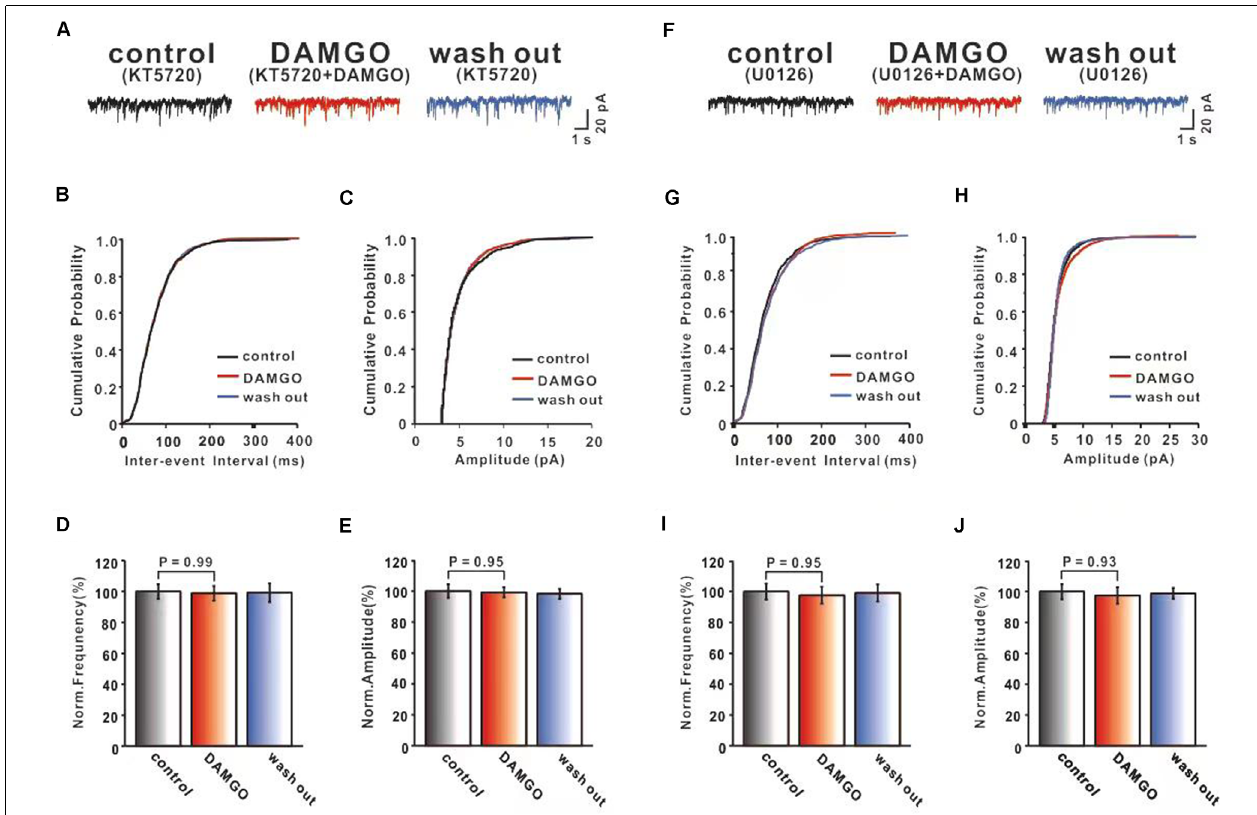
FIGURE 4 | Both PKA inhibitor KT5720 and MEK inhibitor U0126 can block DAMGO induced inhibition of PF-PC synaptic transmission. (A) Representative traces of PF-PC mEPSCs in control (1 µ M KT5720), DAMGO (2 µ M DAMGO + 1 µ M KT5720), and washout conditions (1 µ M KT5720). (B,C) Cumulative probability plots of PC mEPSCs frequency (interevent interval) (B) and amplitude (C) in control (1 µ M KT5720), DAMGO (2 µ M DAMGO + 1 µ M KT5720), and washout conditions (1 µ M KT5720). (D,E) Bar graphs showing the effects of DAMGO (2 µ M) on the PF-PC mEPSCs frequency (D) and amplitude (E) in the presence of KT5720 (1 µ M) in ACSF. (F) Representative traces of PF-PC mEPSCs in control (10 µ M U0126), DAMGO (2 µ M DAMGO + 10 µ M U0126), and washout conditions (10 µ M U0126). (G,H) Cumulative probability plots of PF-PC mEPSCs frequency (interevent interval) (G) and amplitude (H) in control (10 µ M U0126), DAMGO (2 µ M DAMGO + 10 µ M U0126), and washout conditions (10 µ M U0126). (I,J) Bar graphs showing the effects of DAMGO (2 µ M) on the PF-PC mEPSCs frequency (I) and amplitude (J) in the presence of